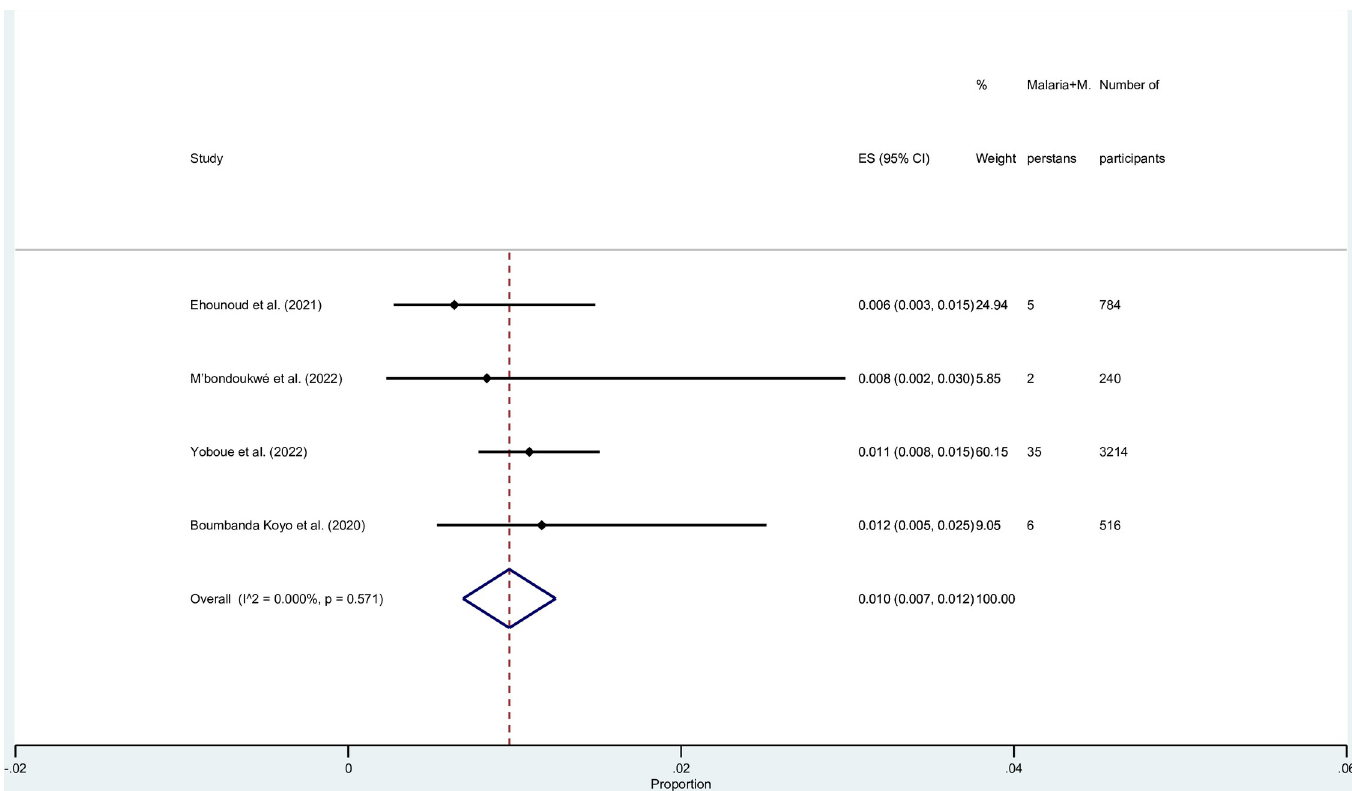
Fig 6. Prevalence of malaria and M . perstans co-infections among selected studies. Abbreviations : ES- prevalence estimate; CI-: confidence interval.